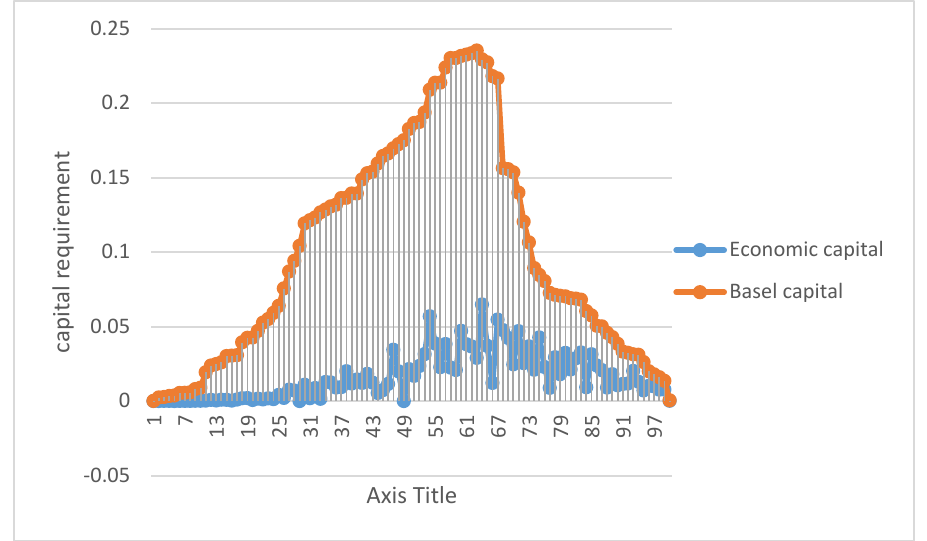
Figure 3. Economic and Regulatory capital requirement.